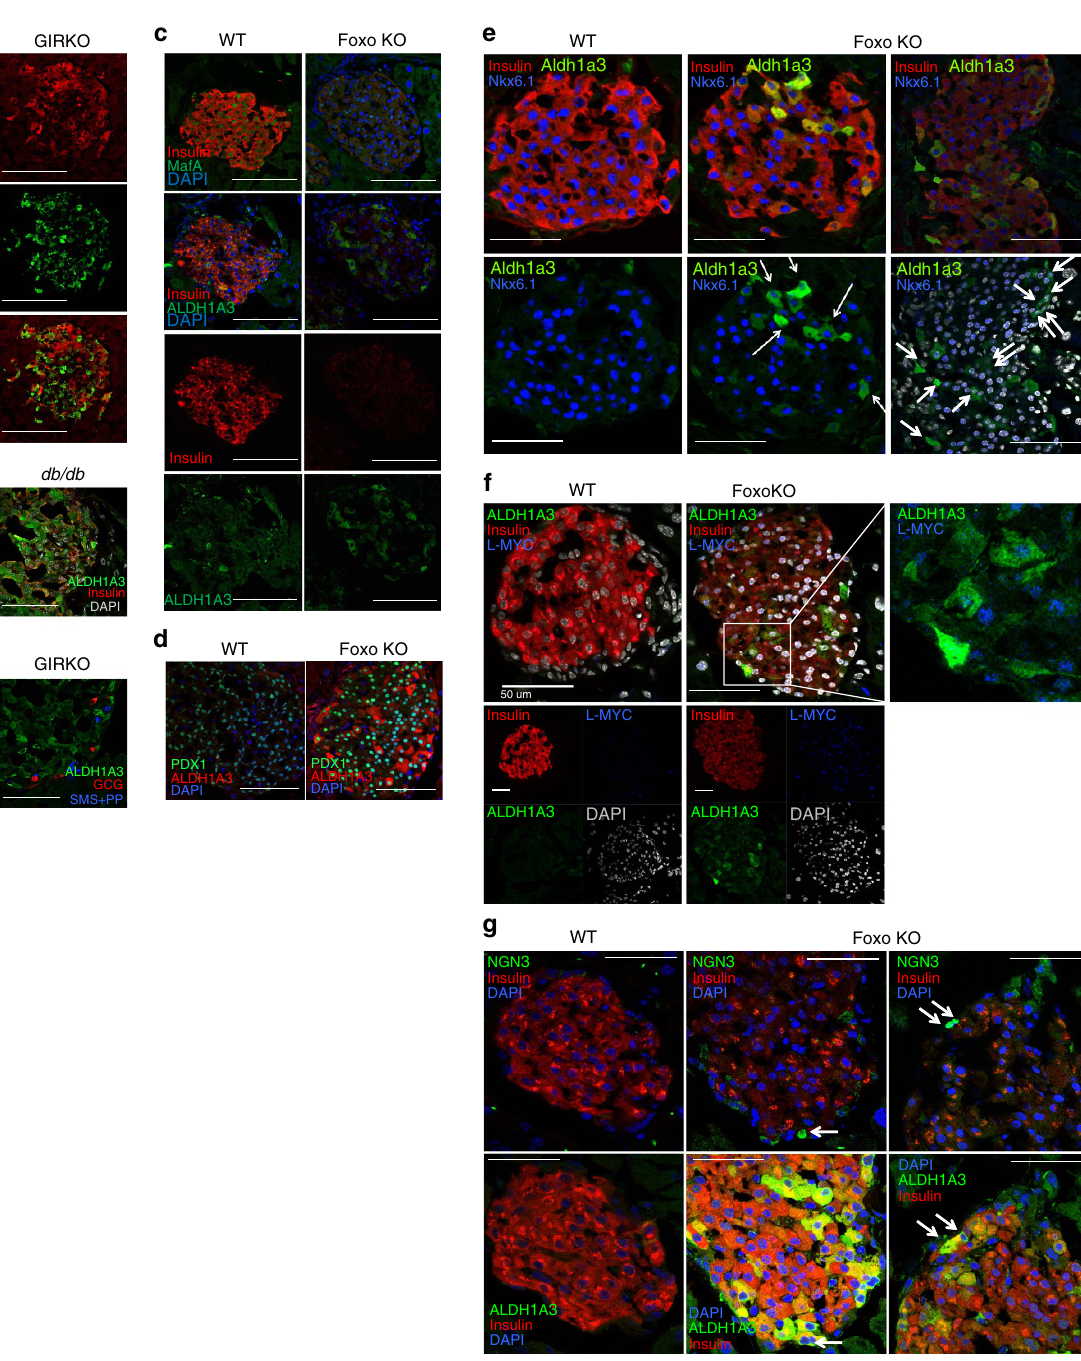
Figure 2 | Localization of ALDH1A3 in mouse islets. ( a ) ALDH1A3 immunoreactivity in islets from normal and diabetic GIRKO mice. ( b ) Co-immunostaining of ALDH1A3 and insulin or glucagon, somatostatin (Sms), and Pp in db/db, GIRKO, and Pdx1-cre-driven Foxo knockout mice. ( c – e ) Co-immunostaining of ALDH1A3 with MafA ( c ), Pdx1 ( d ), or Nkx6.1 ( e ). ALDH þ /Nkx6.1 (cid:3) cells are indicated by the white arrows. MafA/ALDH1A3 ( c ) immunohistochemistry was performed on consecutive sections, whereas Pdx1/ALDH1A3 and NKX6.1/ALDH1A3 immunohistochemistry was performed on the same section. ( f , g ) Co-immunohistochemistry of ALDH1A3 with progenitor cell markers, L-myc ( f ) and neurogenin3 ( g ). ALDH1A3 þ / Neurog3 þ cells are indicated by the white arrows. Neurog3/ALDH1a3 immunohistochemistry was performed on consecutive sections. To better assess Neurog3/ALDH1A3-positive cells, we provide two representative sections from Foxo knockout mice. Scale bar, 100 m M in ( a , c ), scale bar, 50 m M in ( d – g ). In ( b ) left panel scale bar, 100 m M, right panel scale bar, 50 m M. DAPI, ALDH-expressing cells. We used red fluorescent protein (RFP) to dedifferentiating b cells. In wild-type mice, we obtained three sub- label b (or former b ) cells by cre-mediated recombination 7 . populations: RFP (cid:3) ALDH (cid:3) (non- b cells), RFP þ ALDH (cid:3) (healthy b cells), and RFP þ ALDH þ (dysfunctional b cells) (Fig. 4b). The Thereafter, we incubated cells with aldefluor, and selected for RFP latter represented o 1% of total cells in normal islets. In separate (red) and aldefluor (green) fluorescence, yielding ALDH (cid:3) and ALDH þ cells. The latter should include dysfunctional/ experiments, we isolated RFP þ ALDH þ cells from animals with b -